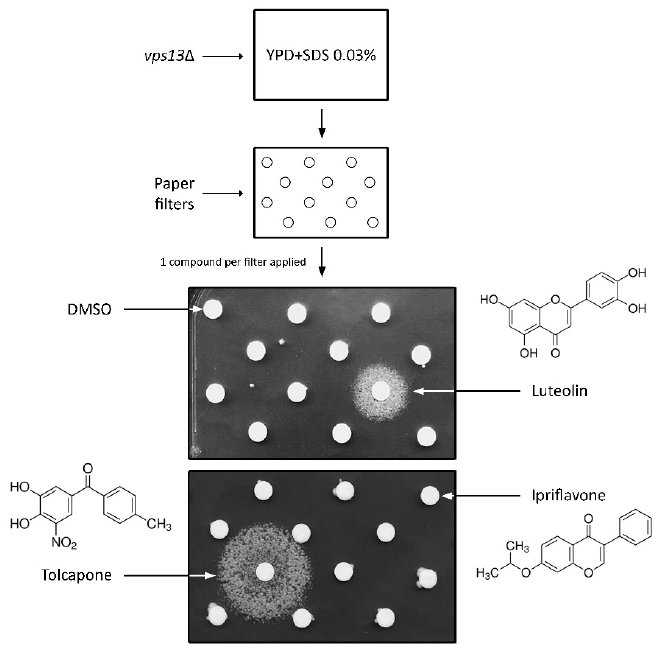
Figure 1. Luteolin and tolcapone are chemical suppressors of vps13 ∆ growth defect. The vps13 ∆ cells were plated on YPD + SDS 0.03%. Compounds from the Prestwick library were applied on filter discs (2 µ L of 10 mM solution in DMSO). DMSO was used as a negative control. Plates were incubated for 3